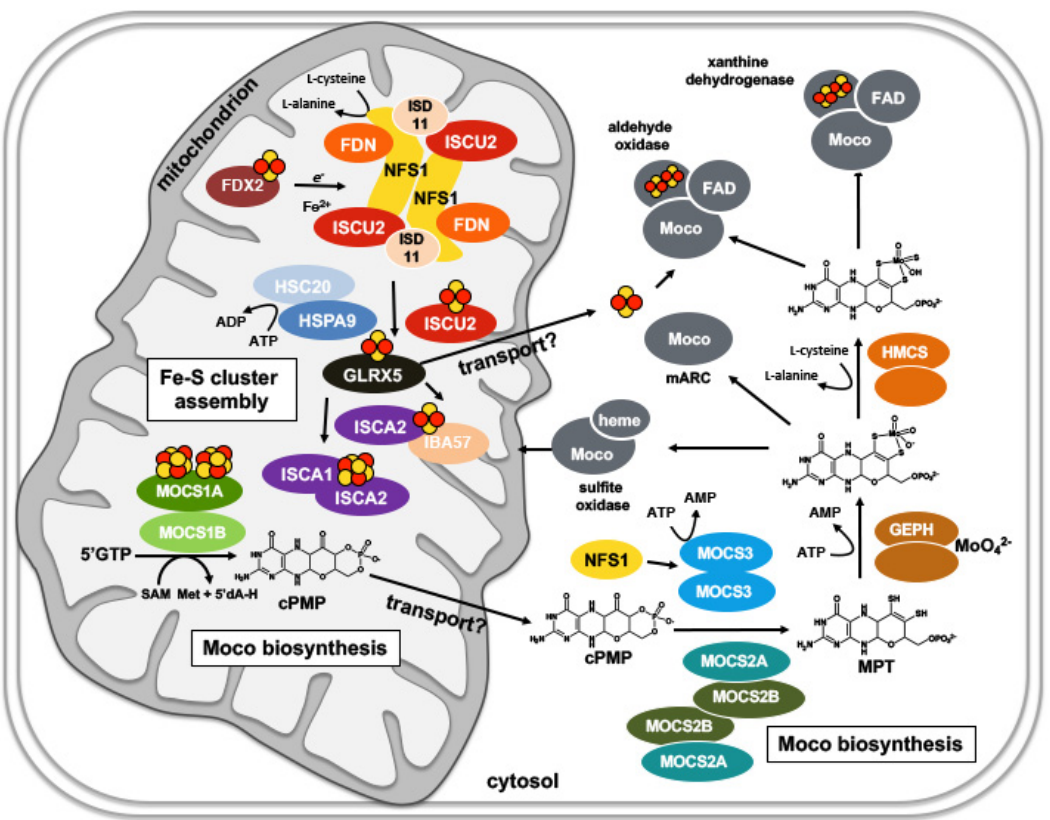
Figure 8. The different compartments for the biosynthesis of Moco in humans and the link to Fe-S cluster assembly in mitochondria. The first step of Moco biosynthesis, the conversion of 5’GTP to cPMP catalyzed by MOCS1A and MOCS1B, is localized in mitochondria. This is also the main compartment for Fe-S cluster biosynthesis in eukaryotes. Fe-S clusters assemble on the scaffold protein ISCU2, which receives the sulfur from the L -cysteine desulfurase complex NFS1/ISD11. Frataxin (FDN) interacts with the NFS1/Isd11-ISCU2 complex to form the quaternary complex. Ferredoxin (FDX2) delivers the electrons for the process. Assembly and release of the clusters from ISCU2 are facilitated by the chaperones HSC20/HSPA9. The carrier proteins GLRX5, ISCA2, and/or IBA57 deliver the Fe-S clusters to target proteins, like MOCS1A in Moco biosynthesis. Synthesized cPMP by MOCS1A/B needs to be transferred to the cytosol, where all further modification steps of Moco are catalyzed. These steps involve the conversion of cPMP to MPT by MOCS2A/MOCS2B (which are activated by MOCS3), the insertion of molybdate by GEPHYRIN (GEPH), and the insertion of Mo-MPT either to the mARC protein (localized at the outer mitochondrial membrane) or to sulfite oxidase (before its translocation to the mitochondrial intermembrane space). For aldehyde oxidase and xanthine dehydrogenase, the formation of the equatorial sulfido-ligand is transferred by HMCS. Dual localization of NFS1 both in mitochondria and the cytosol is predicted. Cytosolic NFS1 acts as a sulfur donor for MOCS3.